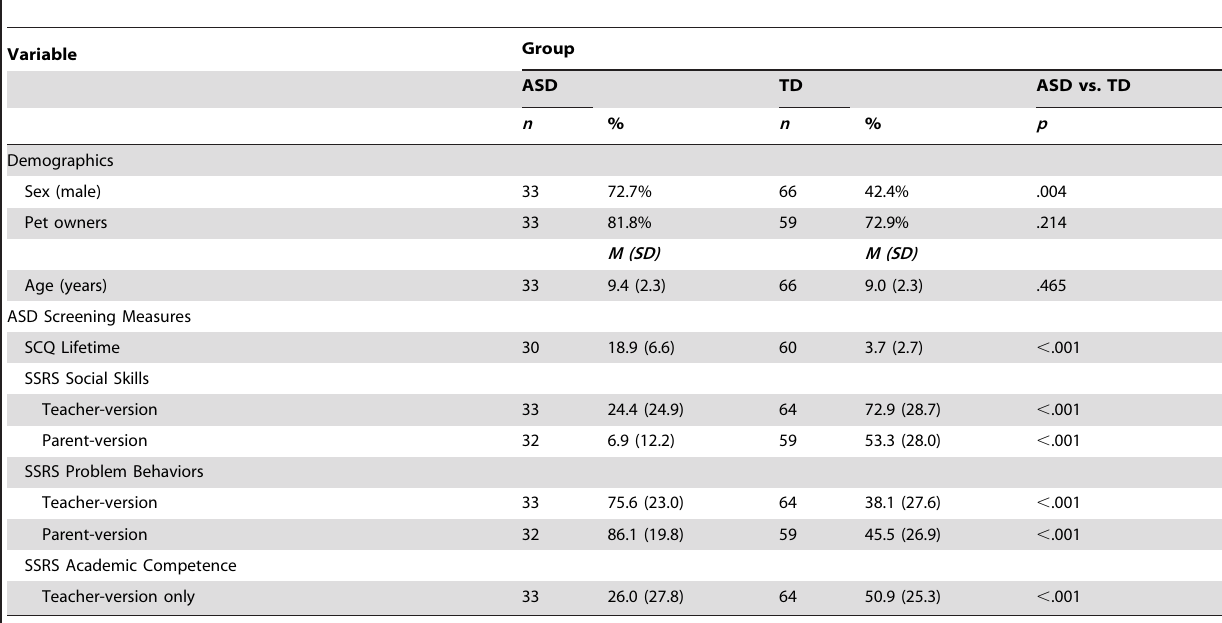
Table 1. Demographic information and ASD screening